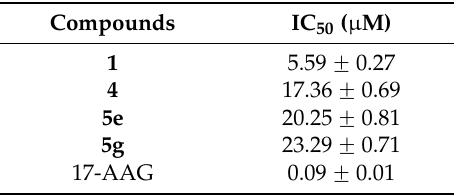
Table 3. Cytotoxicity towards